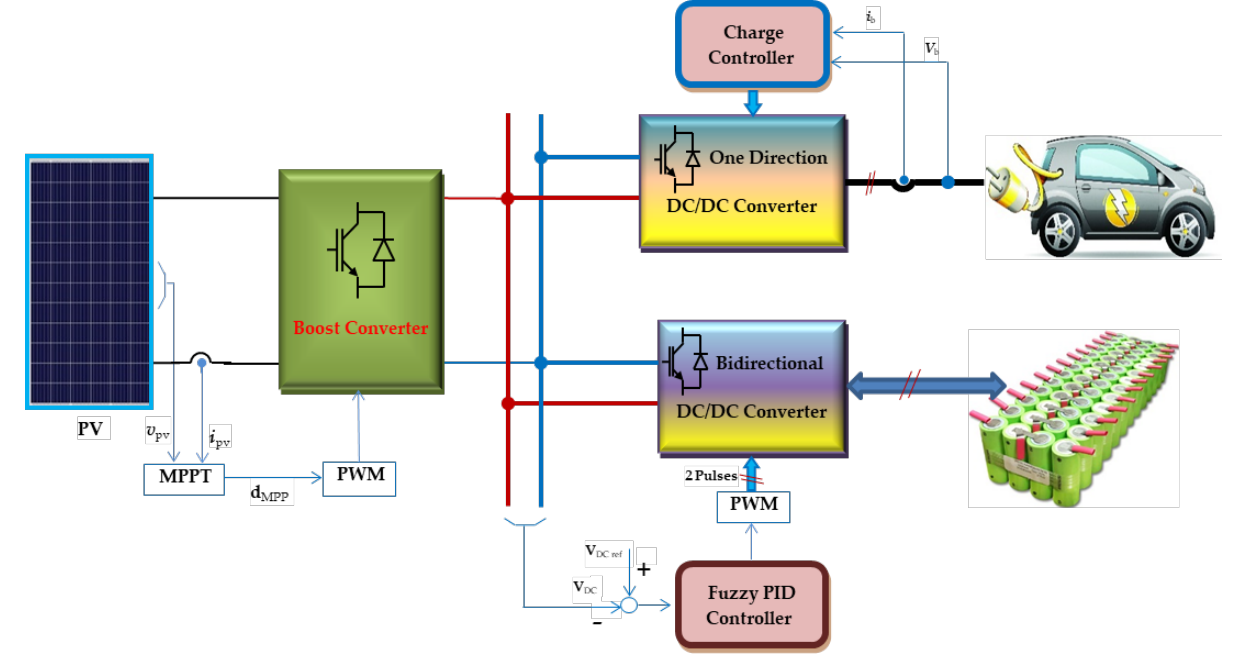
Figure 1. The proposed EV charging station.